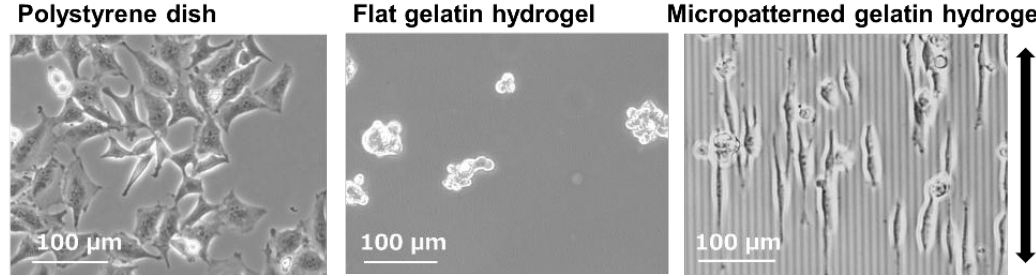
Figure 7. HeLa cell responses on polystyrene dish, flat gelatin hydrogel (~10 kPa), and micropatterned gelatin hydrogel (5 µ m-line-and space).